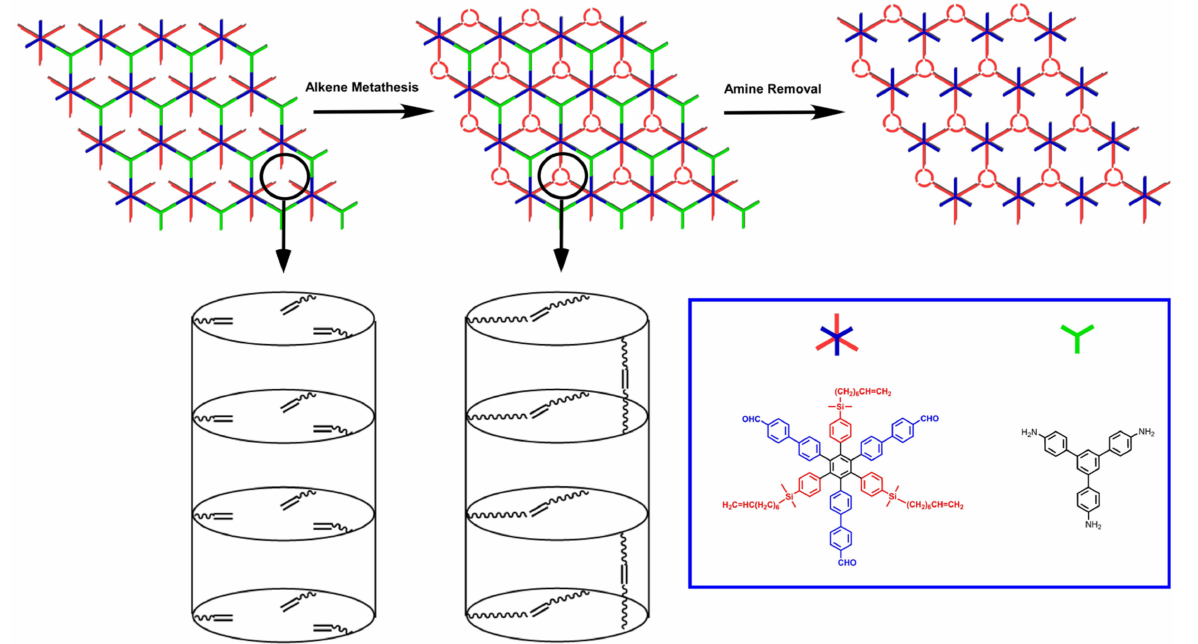
Figure 1. The overall design for hierarchical bond formation within formed COF for the purpose of improving the hydrolytic